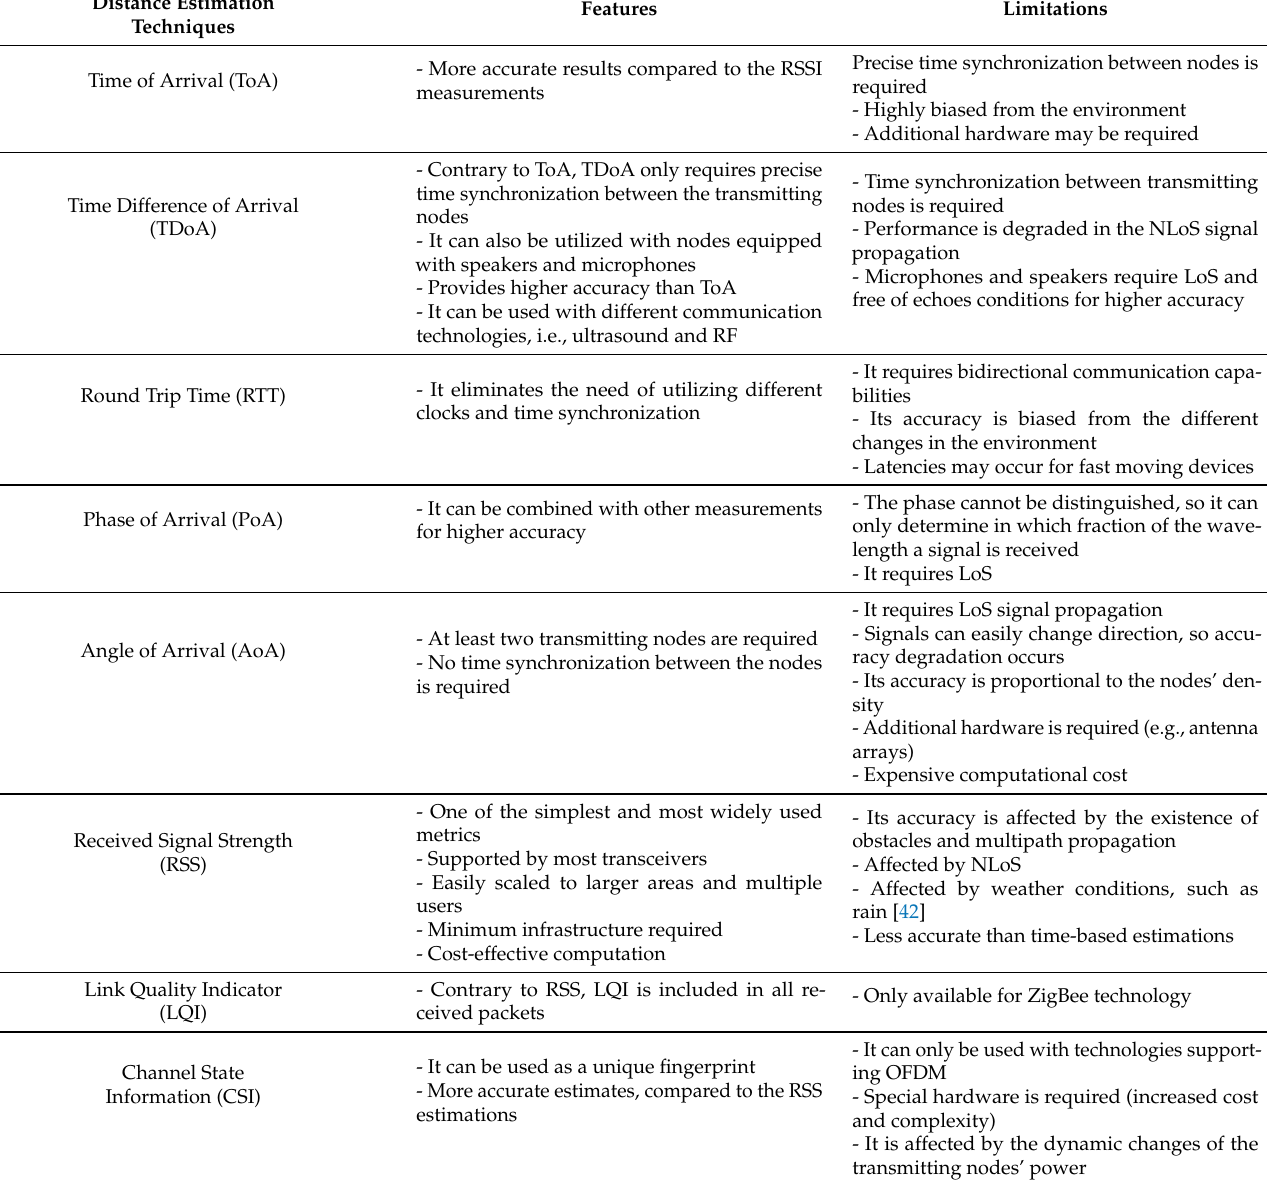
Table 2. Distance Estimation Techniques